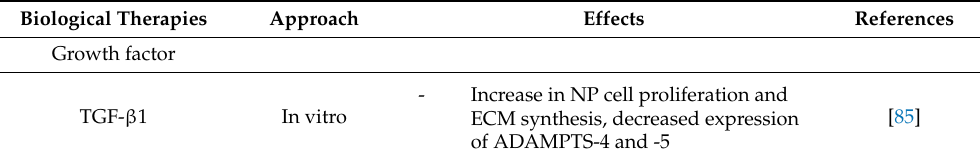
Table 1. Biological therapies in different studies with their